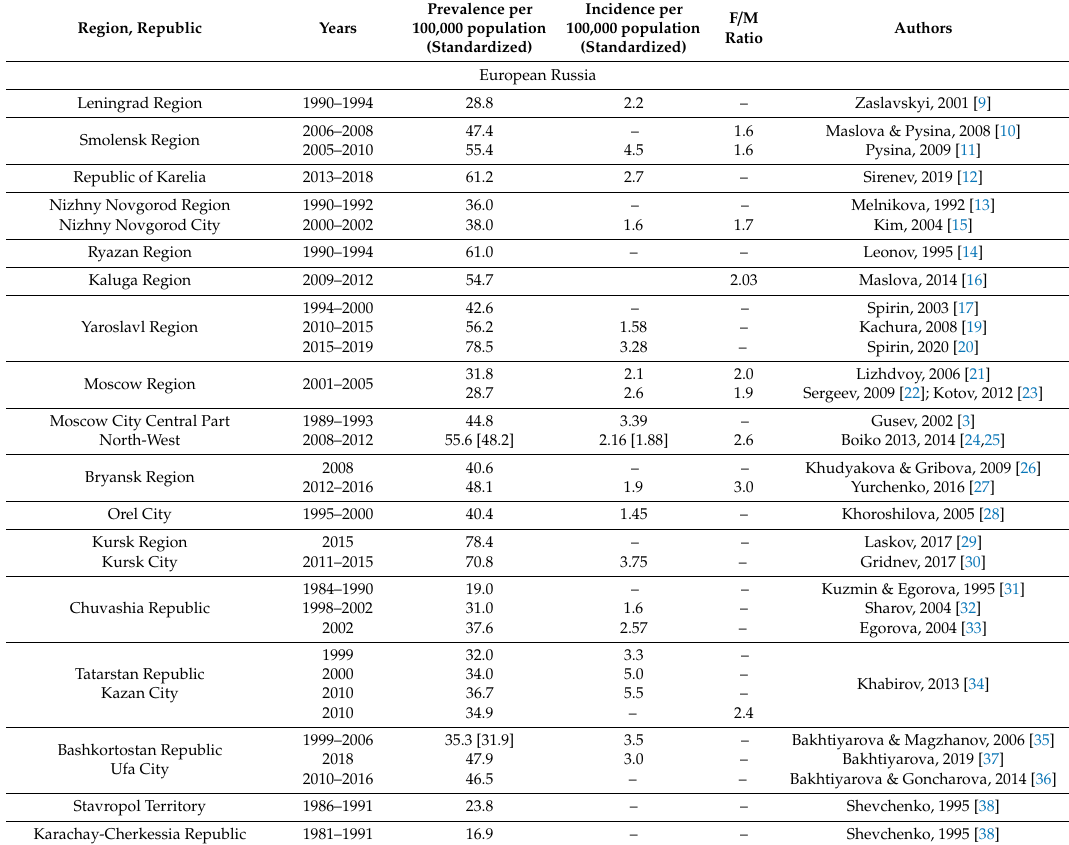
Table 1. Data from the recent epidemiological studies of multiple sclerosis (MS) in the Russian Federation by major regions (standardized values in square